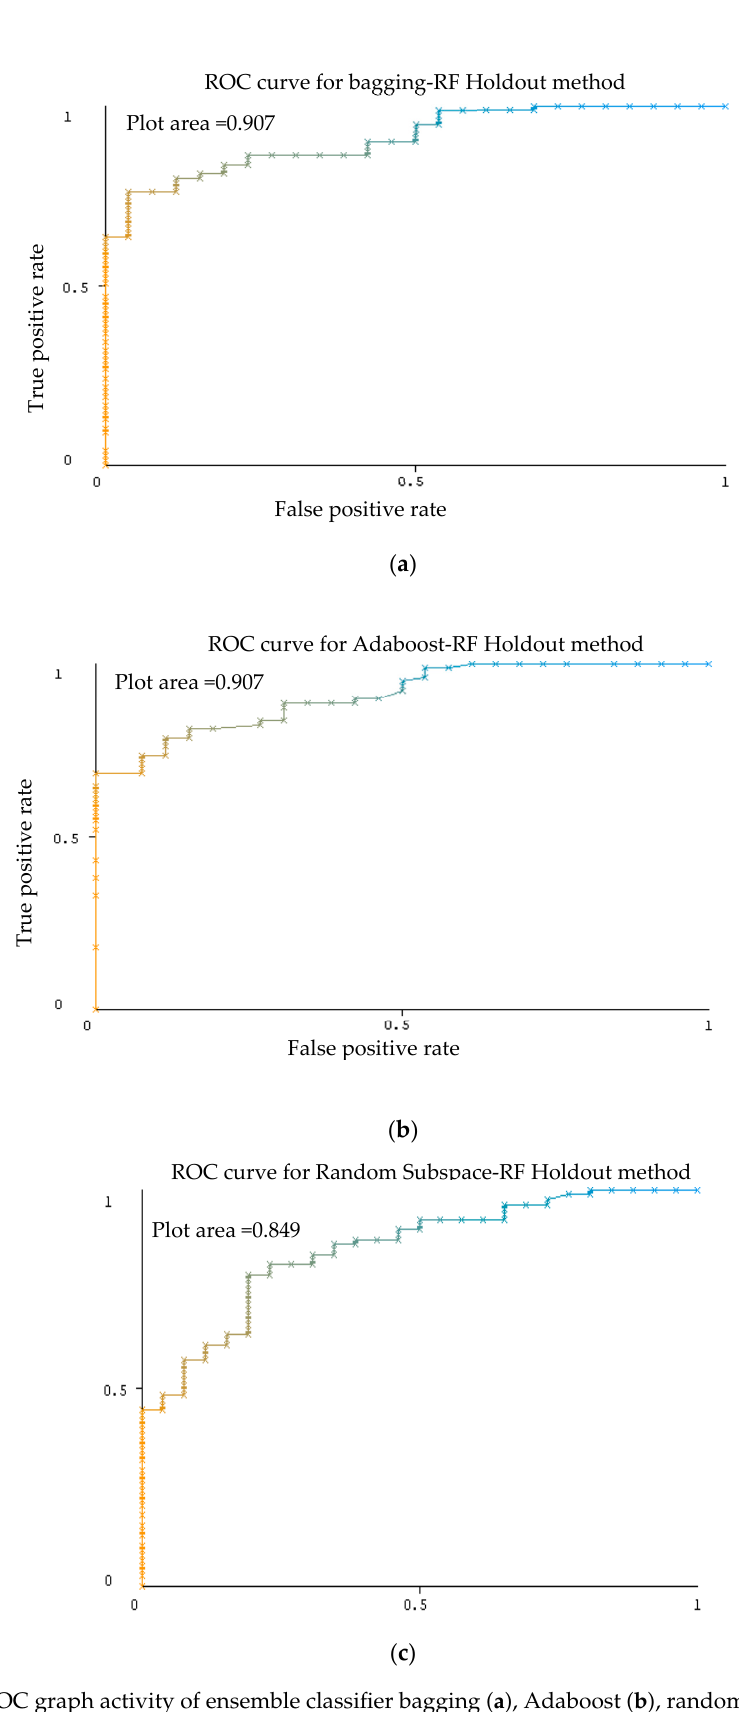
Figure 17. ROC graph activity of ensemble classifier bagging ( a ), Adaboost ( b ), random subspace ( c ) with RF classifier using holdout method Dataset